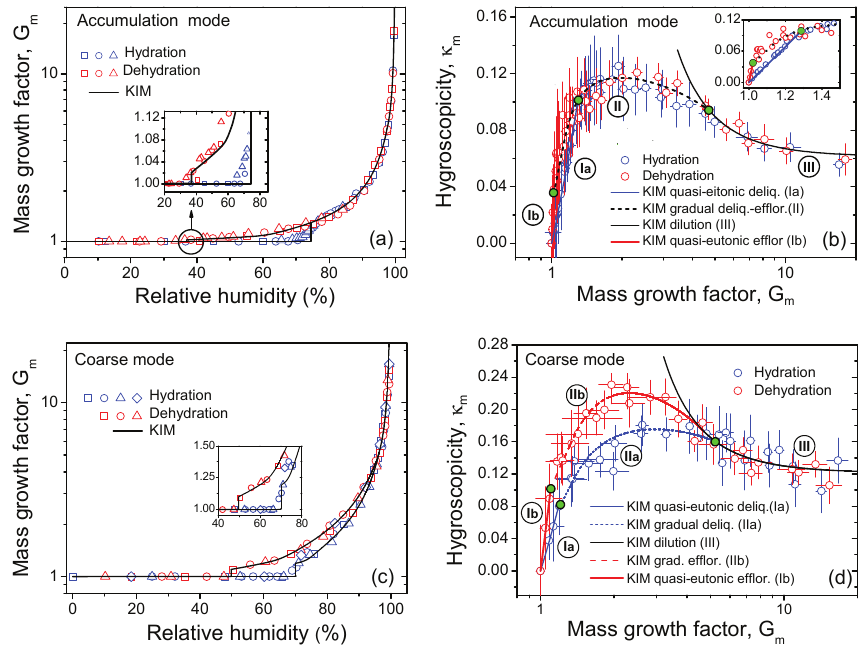
Figure 8. Hygroscopic properties of accumulation (a, b) and coarse (c, d) modes of ZOTTO aerosol samples: (a, c) mass growth factors ( G m ) observed as a function of relative humidity compared to KIM; (b, d) mass-based hygroscopicity parameters ( κ m ) calculated as a function of mass growth factor. The data points and error bars are from FDHA experiments of hydration (blue symbols) and dehydration (red symbols). The labels I (Ia, Ib), II (IIa, IIb) and III indicate different regimes of hygroscopicity (Eqs. 6–8); the borders of the corresponding fit intervals are indicated by green circles (b, d) . Varied symbols in panels (a) and (c) represent different experimental runs on the same